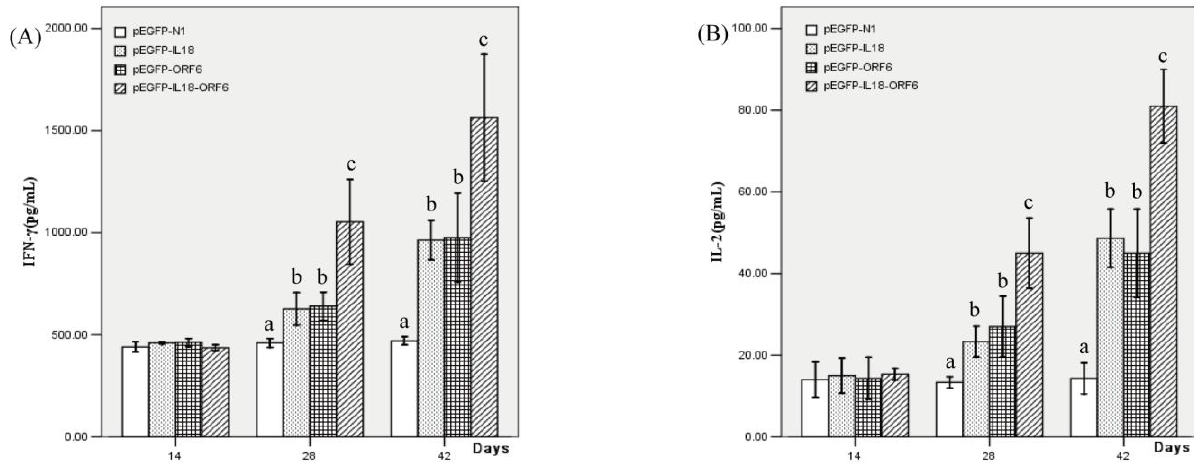
Figure 6. ( A ) IFN-γ level in peripheral blood from piglets inoculated with the recombinant plasmids ( B ) IL-2 level in peripheral blood from piglets inoculated with the recombinant plasmids. Different letters (a, b, c) above the columns at the same time point indicate significant difference ( P < 0.05) between the